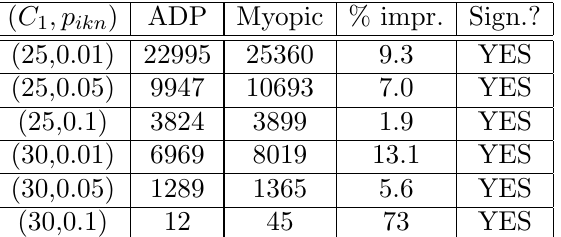
Table 5. Results for the relaxed tol- erance high early scheduling case with N = 10.